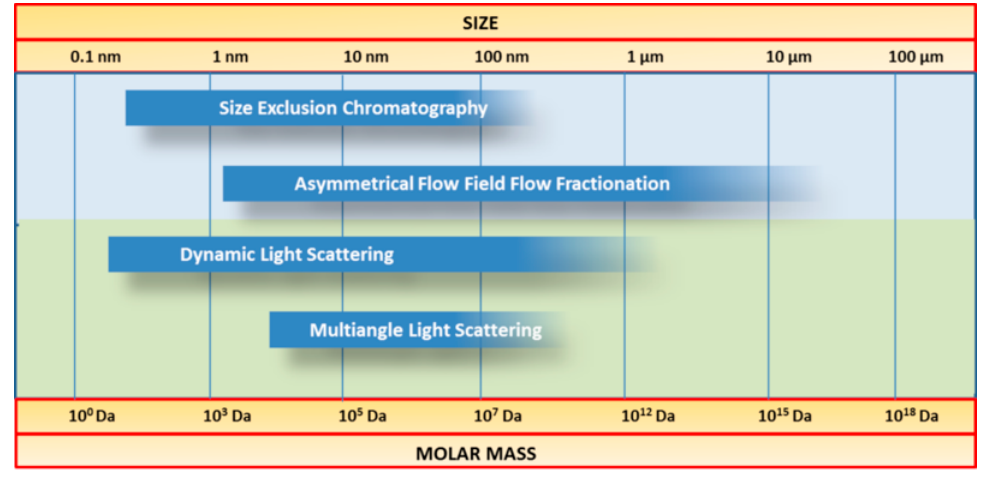
Figure 16. Comparison between the size range of different separation and detection techniques suitable for size determination of casein.